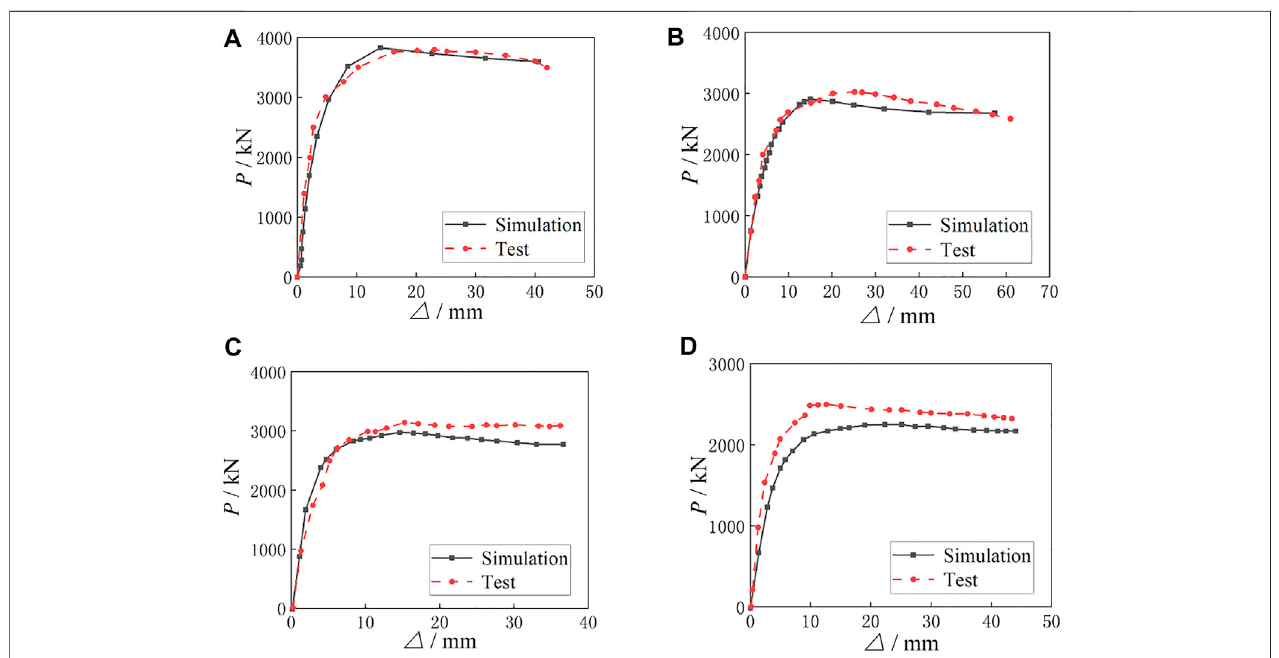
FIGURE 7 | Comparisons of load-displacement curves between simulation and test. (A) Specimen 1-30-10-3. (B) Specimen 1-60-10-4. (C) Specimen 2-30-6-3. (D) Specimen 2-60-6-3.